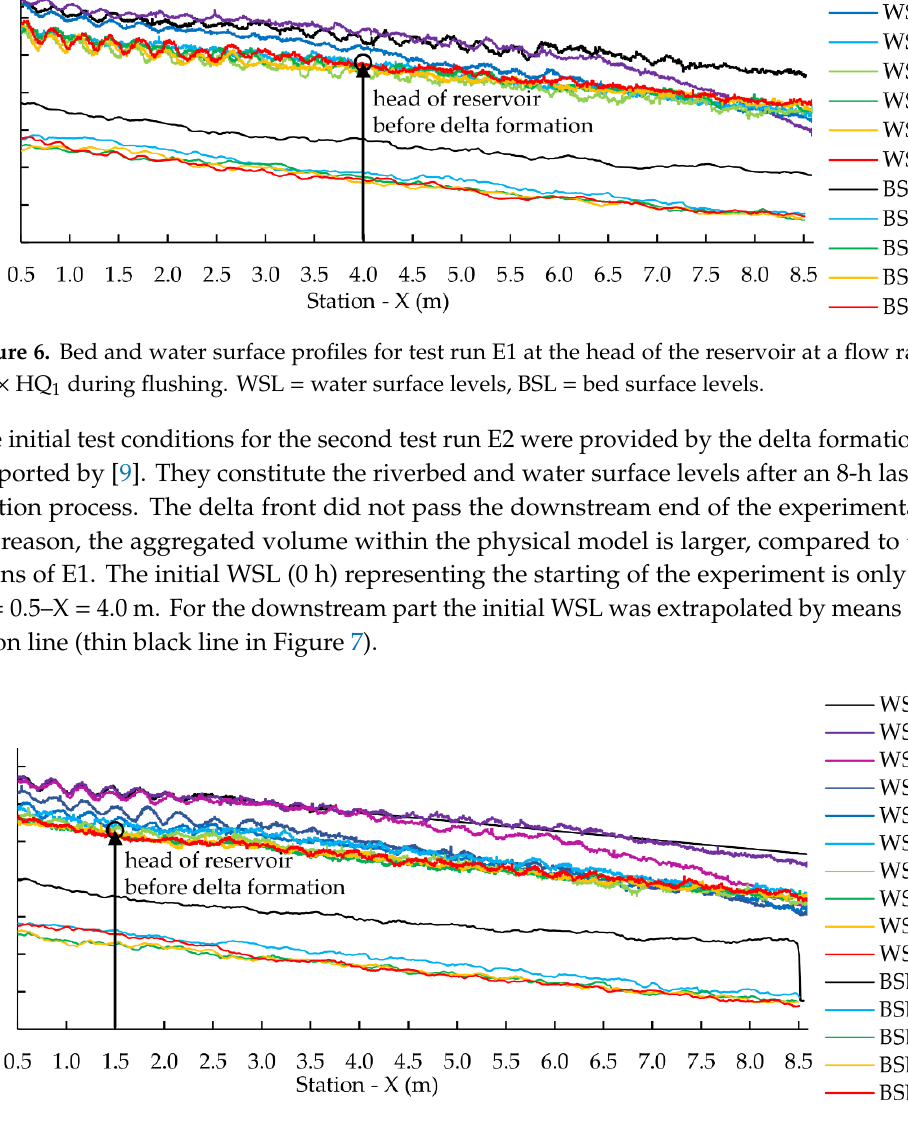
Figure 5. Water surface changes over the experimental time for different stations (X): ( a ) test run E1; ( b ) test run E2.